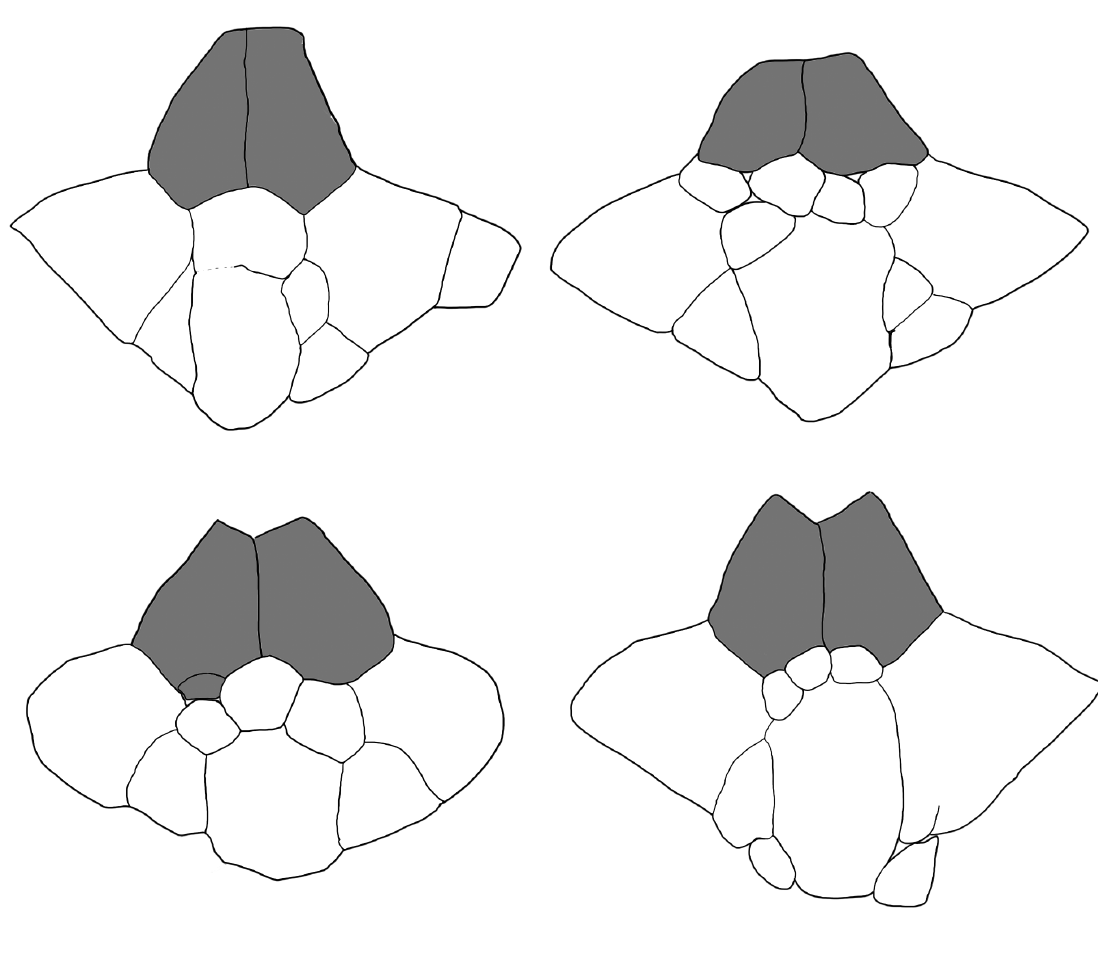
Fig. 7. Anadia mcdiarmidi sp. nov. Intrapopulation variation in the condition of the parietals and the interparietal (frontoparietals in grey). Top, from left to right: IRSNB 2677, IRSNB 2676; bottom, from left to right: IRSNB 2675, IRSNB 2674. Drawings not to